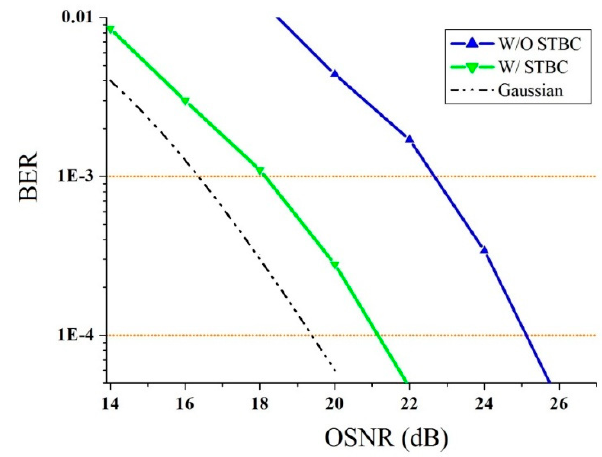
Figure 18. The BER vs. OSNR comparison for PDM-64QAM signal in LP 11a mode with or without using the STBC-RLS scheme [31].